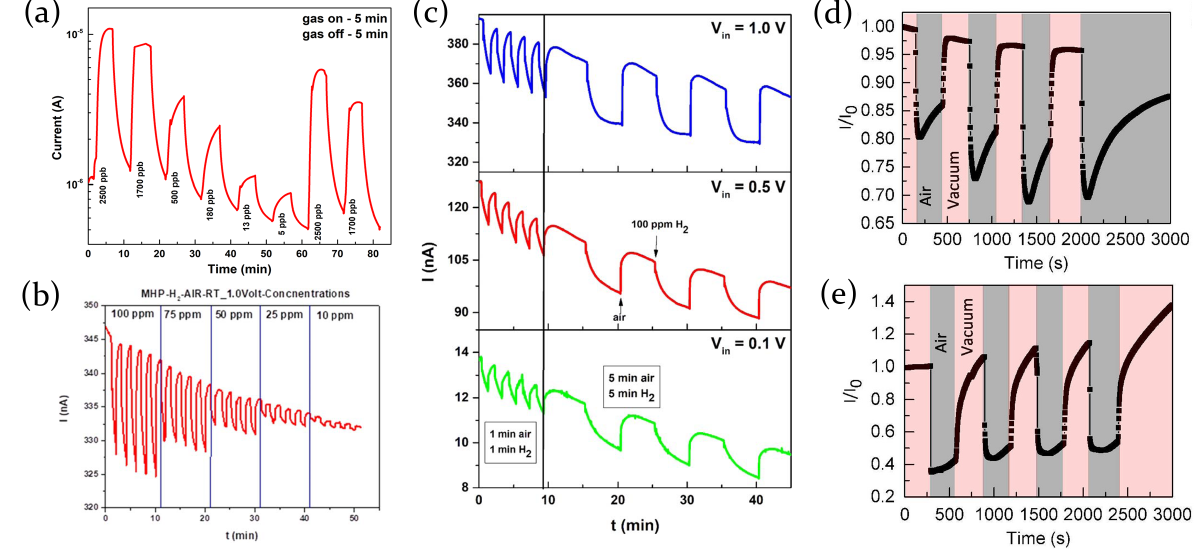
Figure 18. ( a ) Electrical response of MAPbI 3 − x Cl x films under various ozone concentrations (5–2500 ppb). Adapted with permission from [98]. Copyright © 2017, American Chemical Society. https://pubs.acs.org/doi/10.1021/acssensors. 7b00761. Further permission should be directed to the ACS. ( b ) Reversible current modulation for 300 nm thick mixed MAPbI 3 − x Cl x perovskite films under exposure (for five minutes) in various hydrogen concentrations, revealing a detection limit of 10 ppm of H 2 . ( c ) Current modulation of mixed MAPbI 3 − x Cl x perovskite layers under H 2 and air flow, for various exposure times (one and five minutes) and under different forward biases (0.1, 0.5 and 1 Volt). Adapted with permission from [8] under the terms of the Creative Commons Attribution 3.0 license. Copyright © 2020, IOP Science. ( d ) Dark current and ( e ) photocurrent modulation for MAPbBr 3 perovskite measured under vacuum and standard atmosphere. Reprinted from [71], with permission of AIP Publishing; Copyright ©